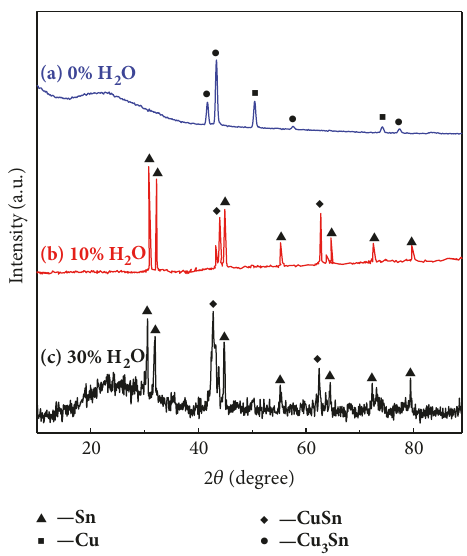
Figure 6: XRD patterns of tin deposits obtained from the [Bmim]HSO 4 ionic liquid containing 40mM SnO with different water content: (a) 0% H 2 O, (b) 10% H 2 O, and (c) 30% H 2 O.